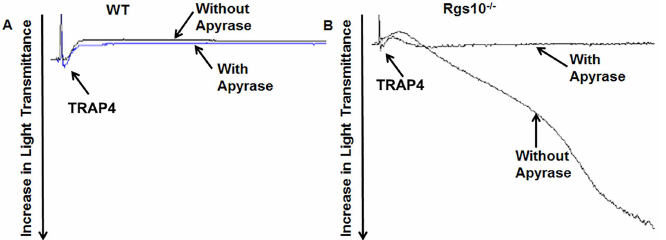
Fig 3. Aggregation in response to TRAP4 in the presence or absence of apyrase. Platelets from (A) WT or (B) Rgs10 -/- mice (2 x 10 8 /ml) were incubatedwith 0.5 units of apyrase for 3 minutes, then exposed to 40 μ M TRAP4. Platelet aggregation was measured using constant stirring. Each experiment was repeated at least 3 times, with blood pooledfrom a group of eight mice.